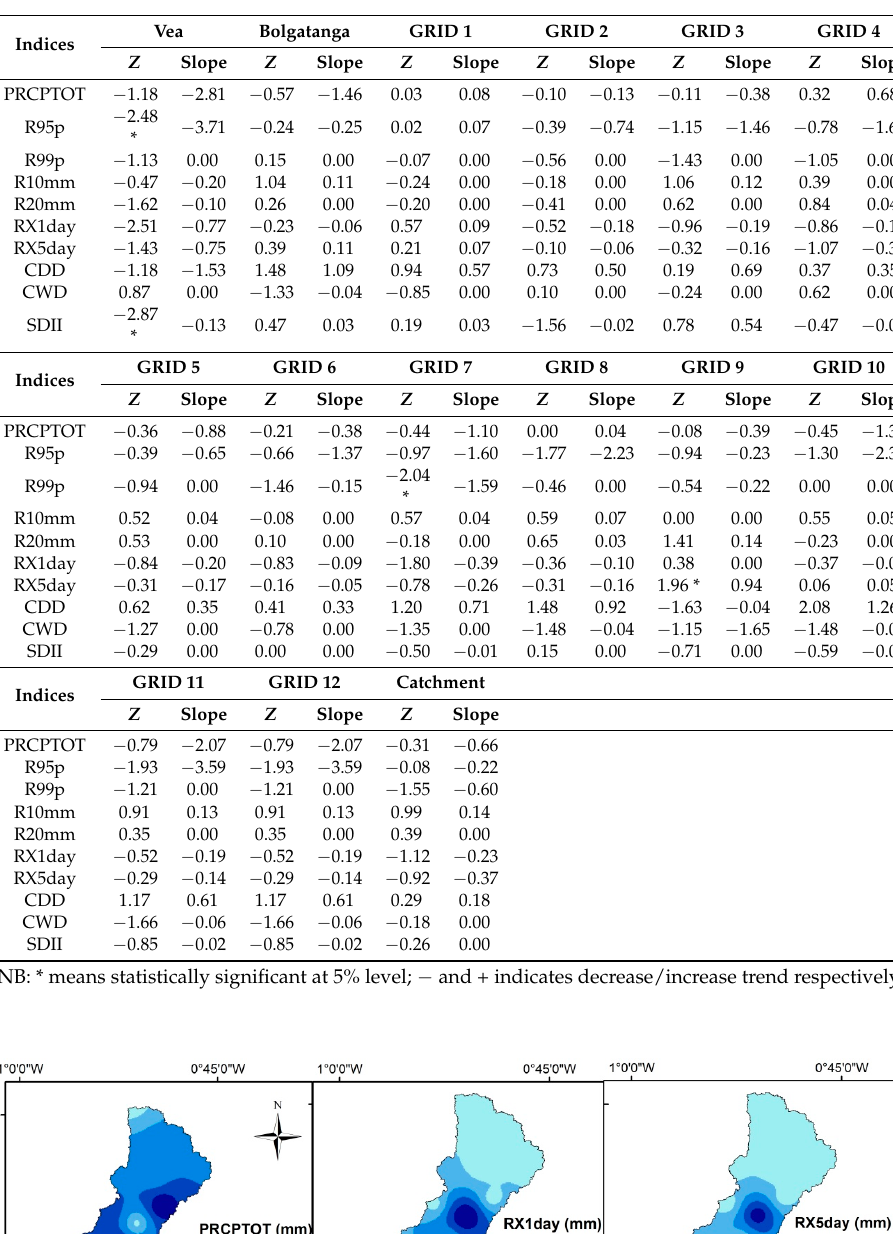
Table 6. Mann–Kendall (MK) Trend Statistics of Rainfall Extreme Indices.